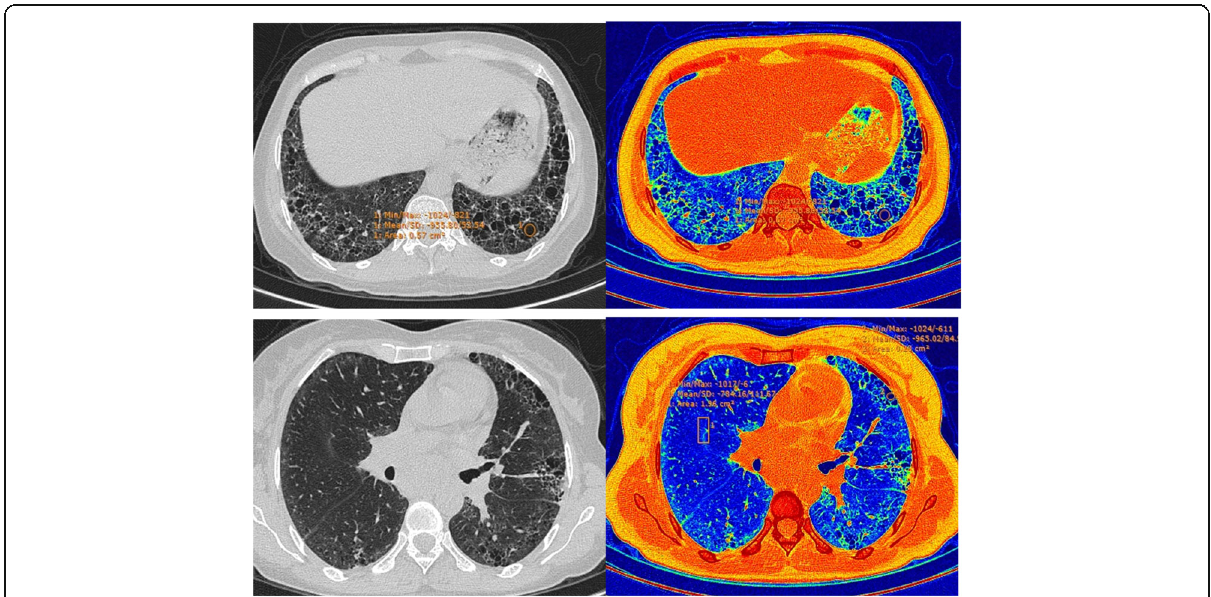
Fig. 4 A 48-year-old female patient presenting with dry cough. Diagnosed as UIP. HRCT axial lung and color-coded image, showing bilateral subpleural ground glass opacification, reticulation, and honeycombing. Area of ground glass opacification and reticulation appear green with microcystic honeycombing appearing as small deep blue lucincies within (ground glass and reticulation ranging above − 750 HU, and honeycombing ranging below − 900 HU), and normal lung appears blue (range HU between − 750 and − 900